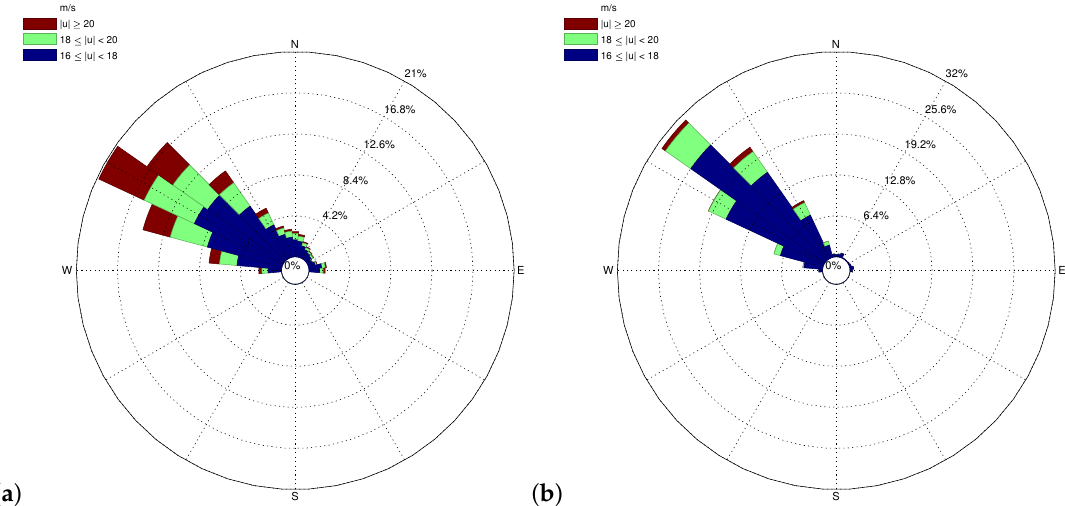
Figure 2. Wind roses for winter ( a ) and summer ( b ) of wind directions for intense wind events in the region considered for the analysis. Events are binned with respect to the wind speed | u | , accordingly to the different values of the threshold used in the